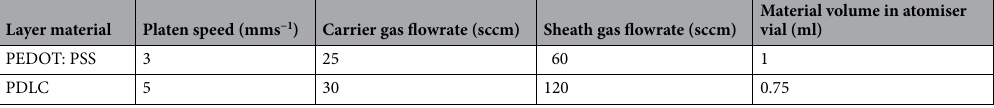
Table 1. Printing parameters for each material.